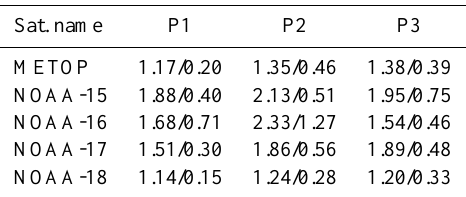
Table A1. (0 ◦ /90 ◦ -flux ratio)/(standard deviation) for P1,P2,P3 pro- ton energy bands.